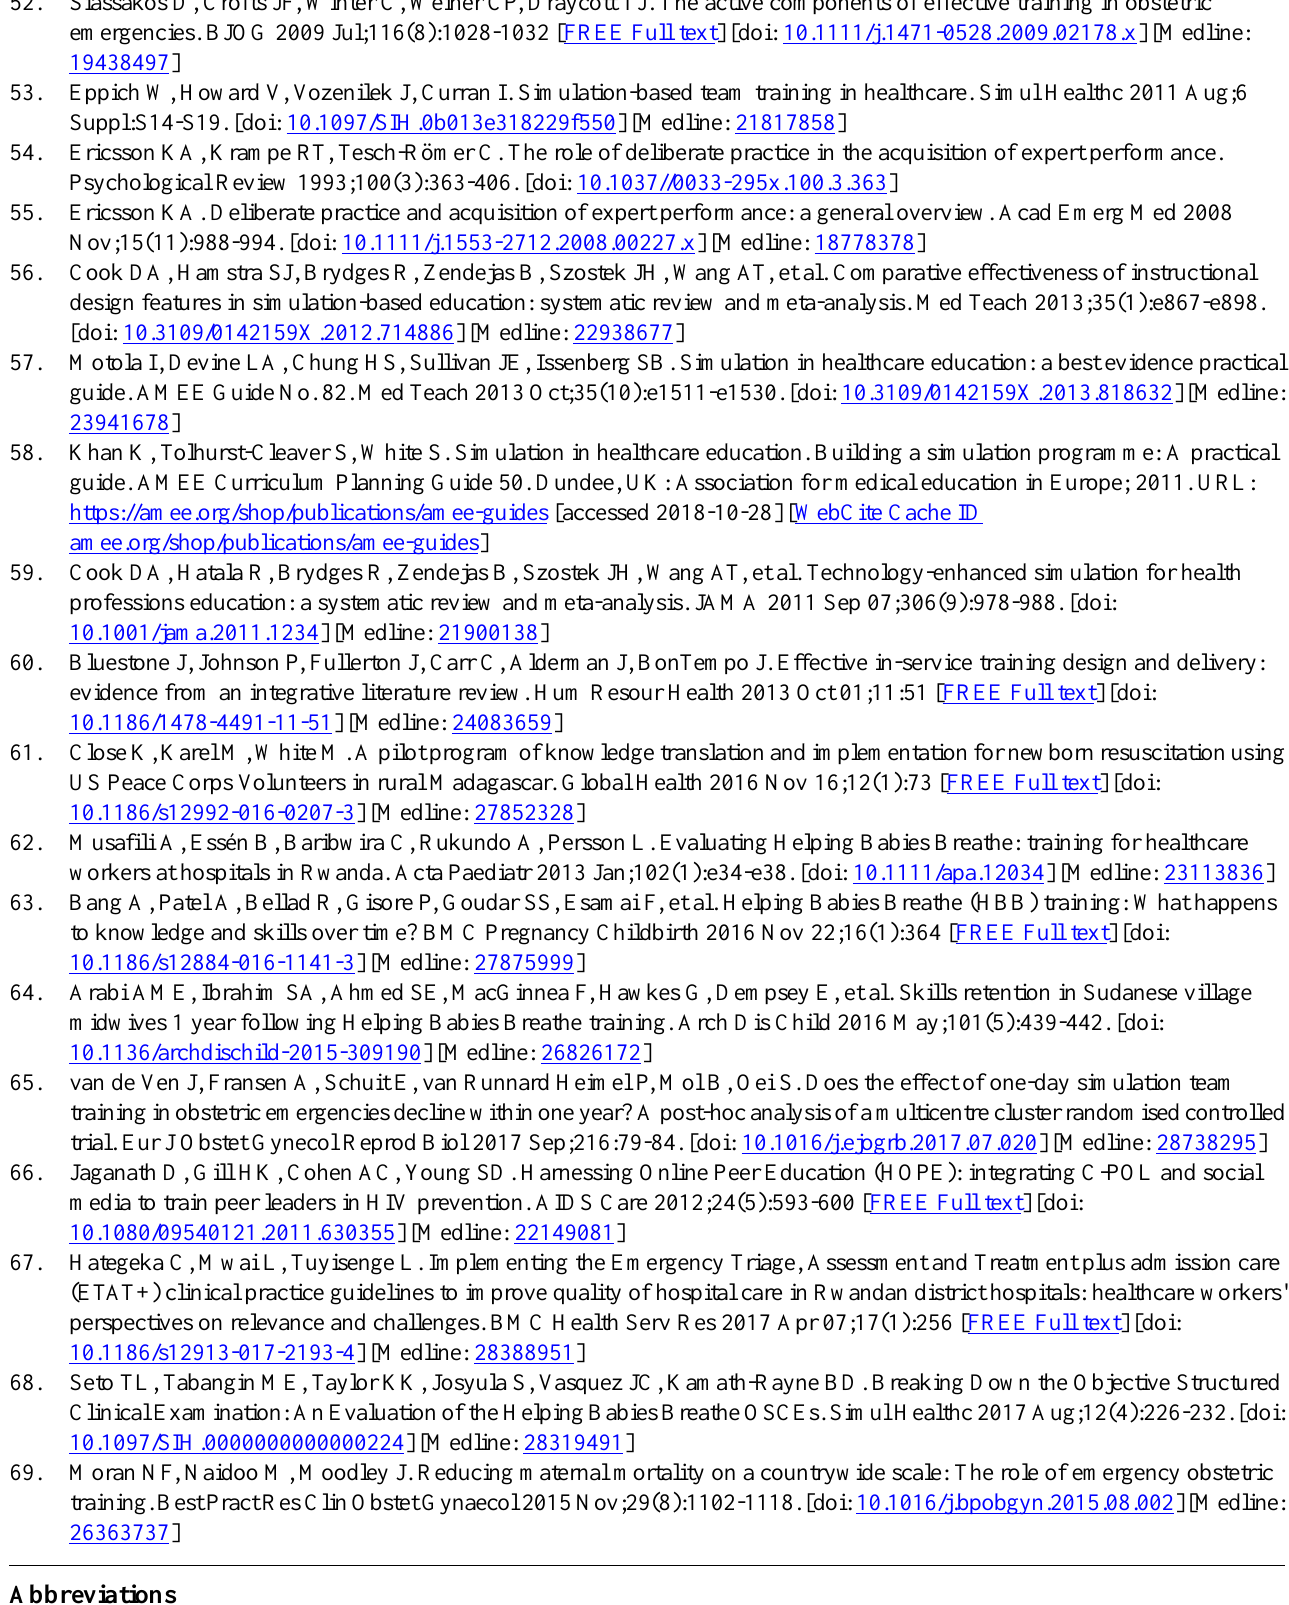
Abbreviations CTS: Clinical Teamwork Scale ID-SIM: Instructional Design of a Simulation Improved by Monitoring SHO: senior house